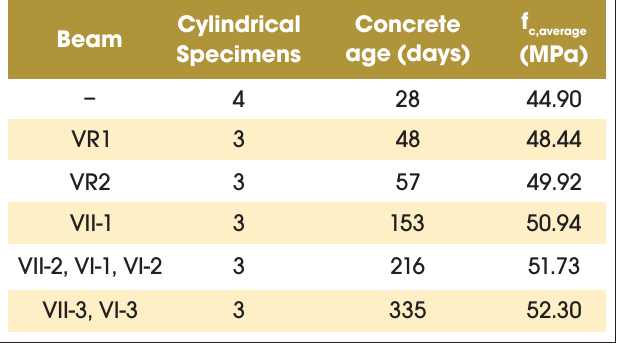
Table 2 – Concrete compressive strength